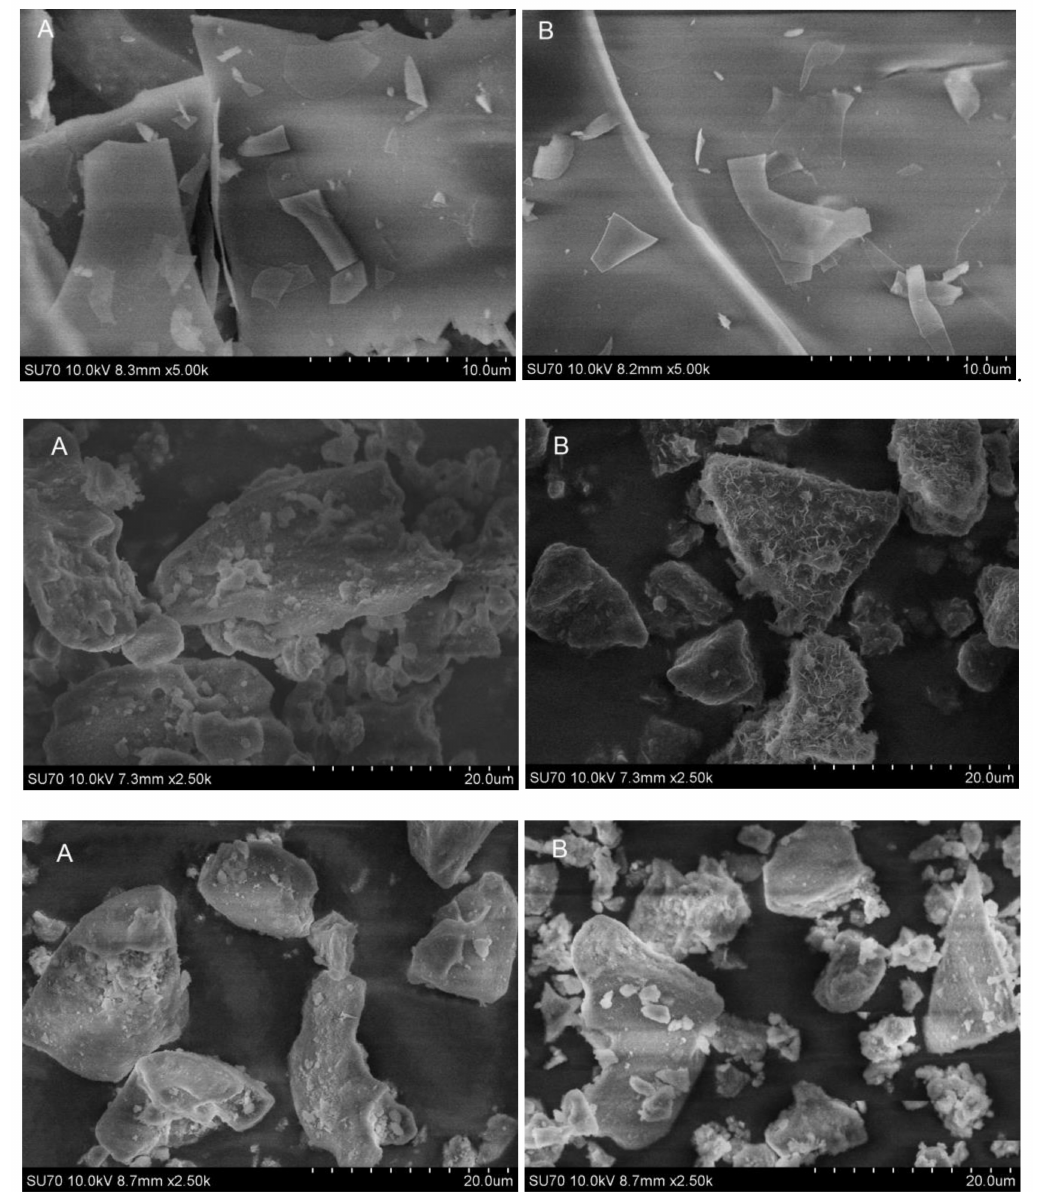
Figure 10. SEM micrographs of MMO obtained by heating the Mg 1.95 Sr 0.05 / Al 1 precursor gels ( top ), sol–gel derived Mg 1.95 Sr 0.05 / Al 1 LDHs ( middle ), and MMO obtained by heating the Mg 1.95 Sr 0.05 / Al 1 LDHs ( bottom ). Annealing temperatures: 800 ◦ C ( A ) and 950 ◦ C ( B